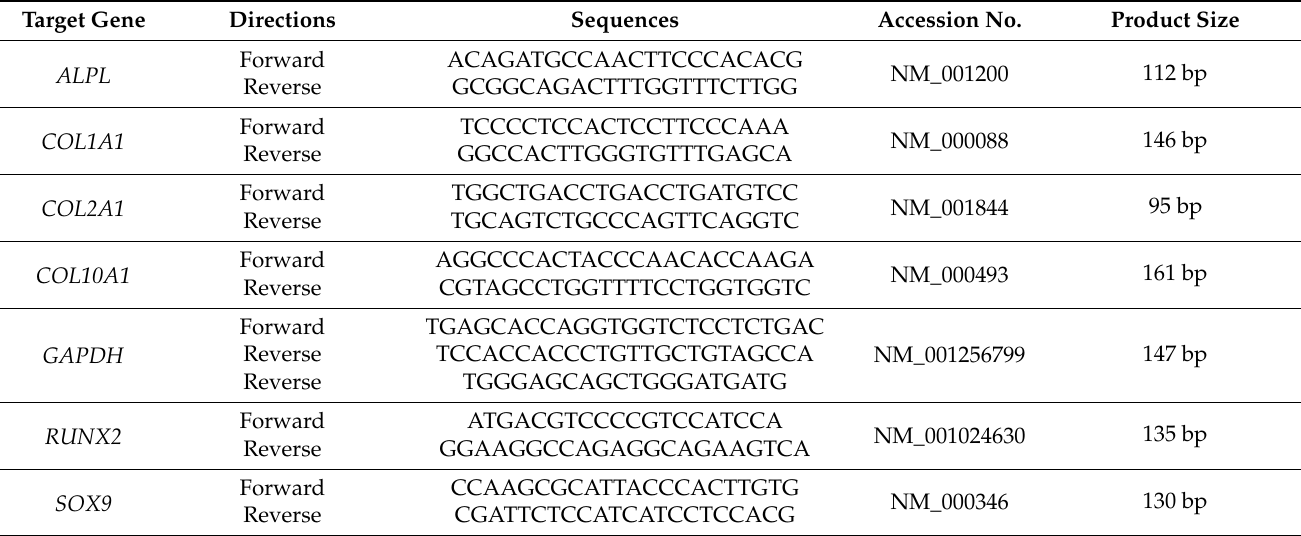
Table 1. Primers for real-time quantitative polymerase chain reaction